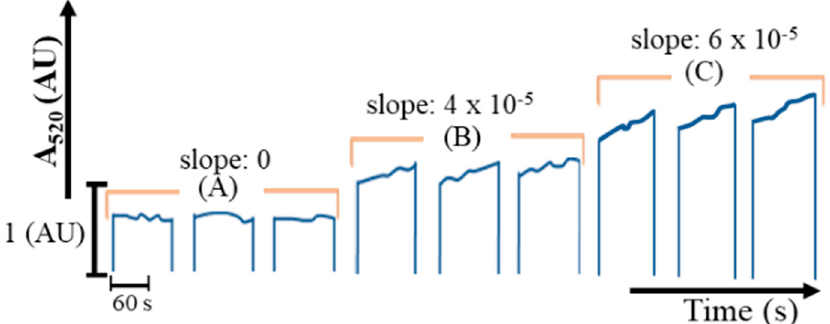
Figure 2. Analytical signal obtained from glucose content in 200 µL. ( A ) 0, ( B ) 2.4, and ( C ) 4 µg.